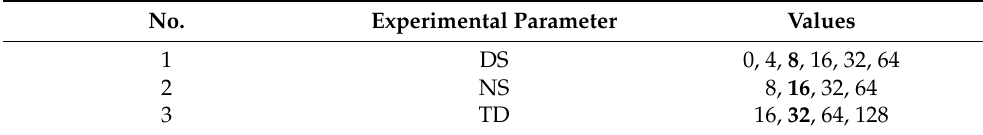
Table 1. All experimental parameters and their variation ranges.